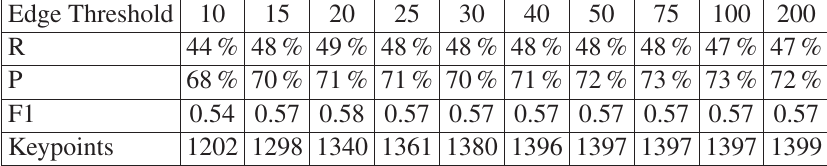
Table 8. Experimental results for various values of vl_sift edge threshold.